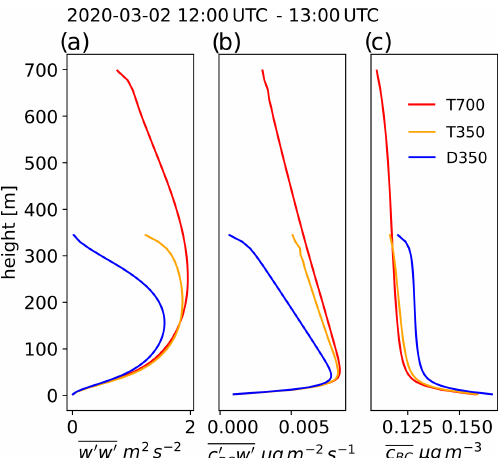
Figure A2. Sensitivity of the vertical turbulent (resolved plus un- resolved) fluxes (a) w (cid:48) w (cid:48) and (b) cBC (cid:48) w (cid:48) on the domain height and the domain-top boundary condition, as well as impact on (c) the mean concentration profile of BC. Run T350 uses the turbulent boundary condition described in the main text of Sect. A3 in com- bination with the default domain height of 350m. Run D350 also uses the default domain height, but a Rayleigh damping layer at the domain top. Run T700 uses same model settings as run T350, but the domain height is doubled to